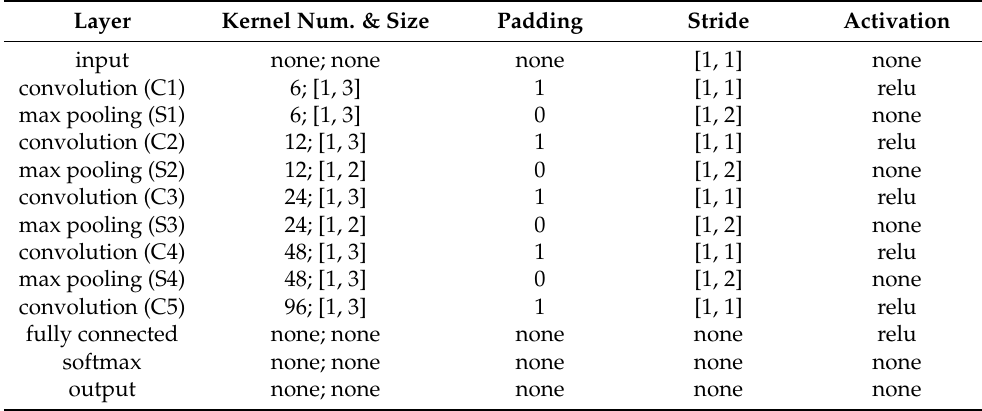
Table 6. The configuration of the CNN for simple supported steel beam database.